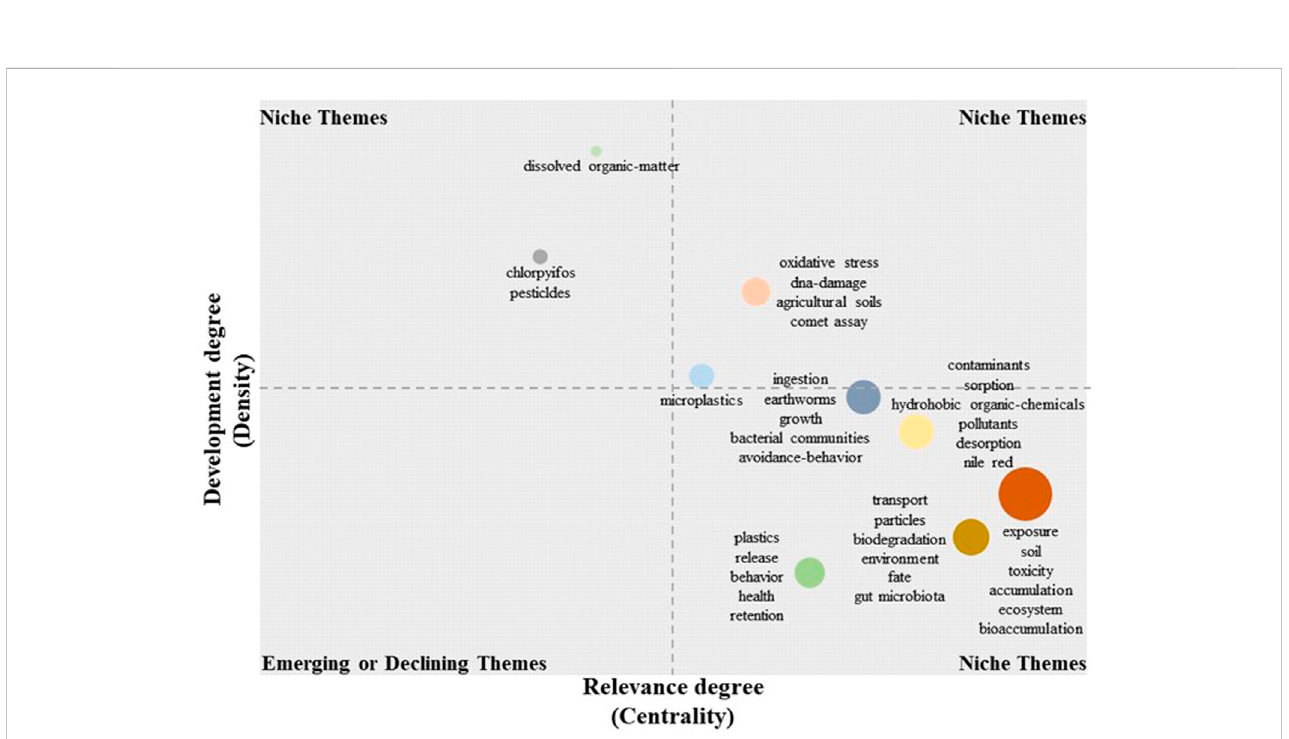
FIGURE 4 Keyword clustering of articles published until December 2021 focusing on the interactions between microplastics and earthworms. The minimum frequency of occurrence (per 1,000 documents) for each research direction is more than fi ve. The size of the circles represents the number of articles published in the corresponding direction. The horizontal axis represents the relevance (centrality), which measures the importance of a research direction in the overall development of the research fi eld. The vertical axis represents development (density), which measures the current state of development of